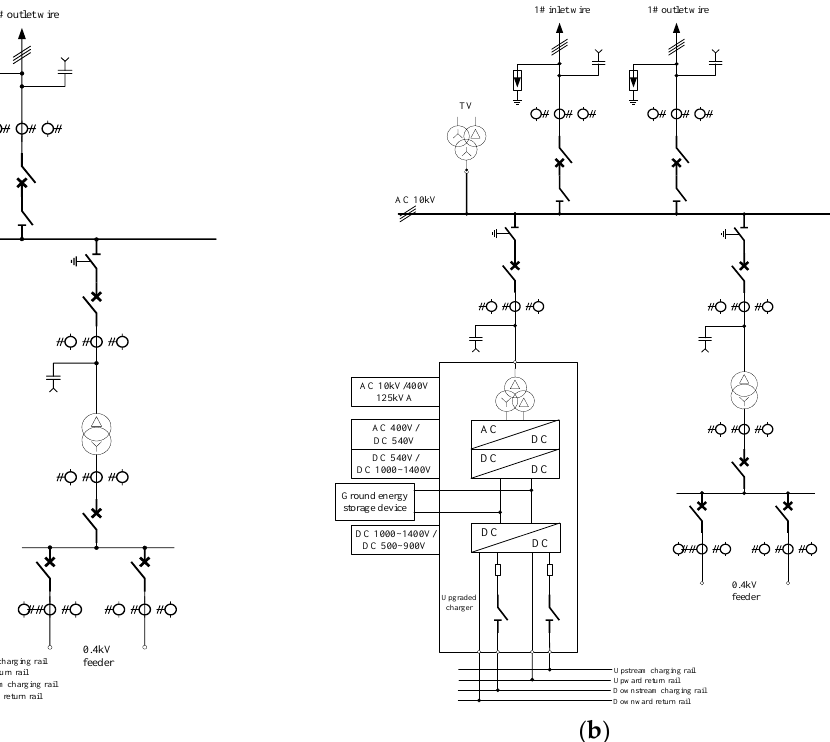
Figure 1. The topology of the charging system. ( a ) Direct charging system. ( b ) Collaborative energy storage system.